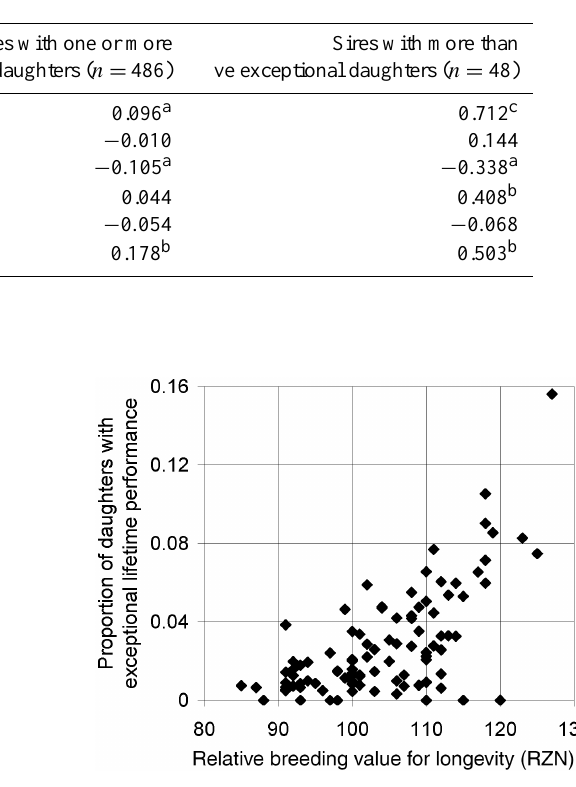
Figure 2. Proportion of exceptional cows compared with the rela- tive breeding values for functional longevity for sires ( n =